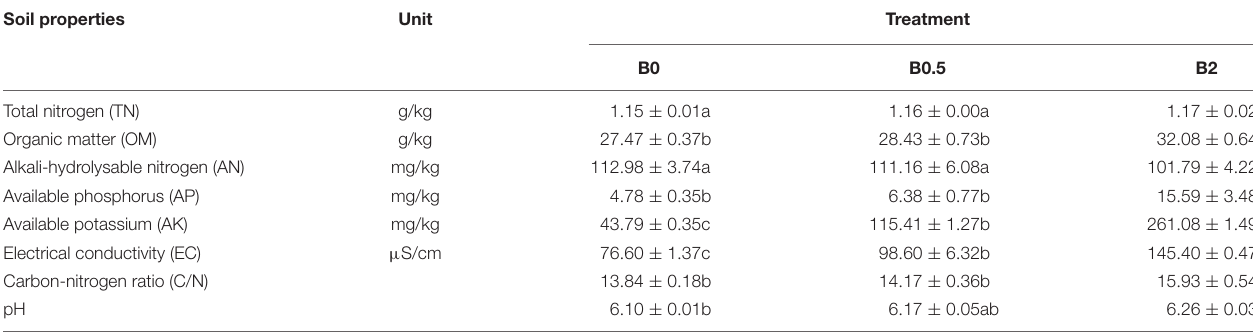
TABLE 1 | Effects of biochar amendment on soil chemical properties.